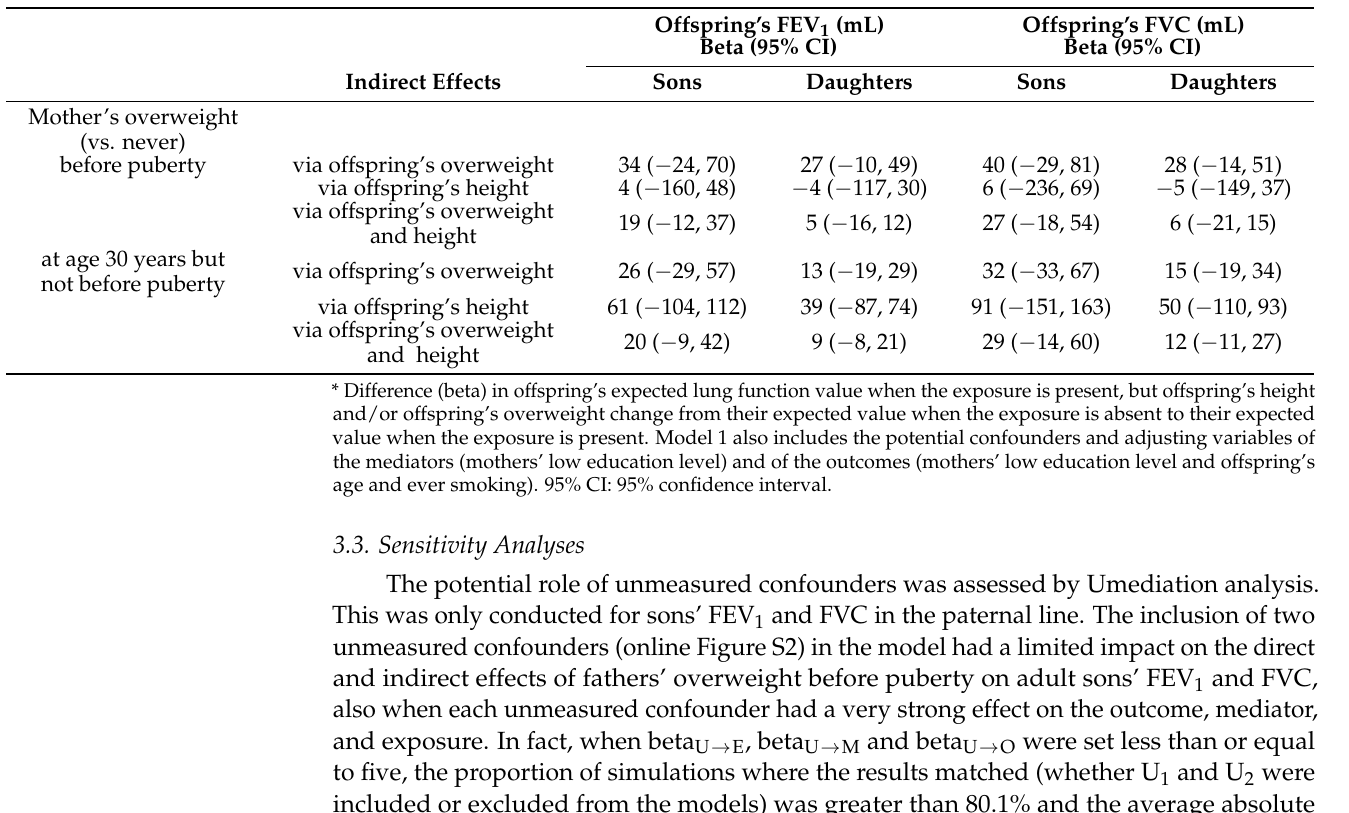
Table 5. Natural indirect effects * on offspring’s pre-bronchodilator FEV 1 and FVC (model 1) within the maternal